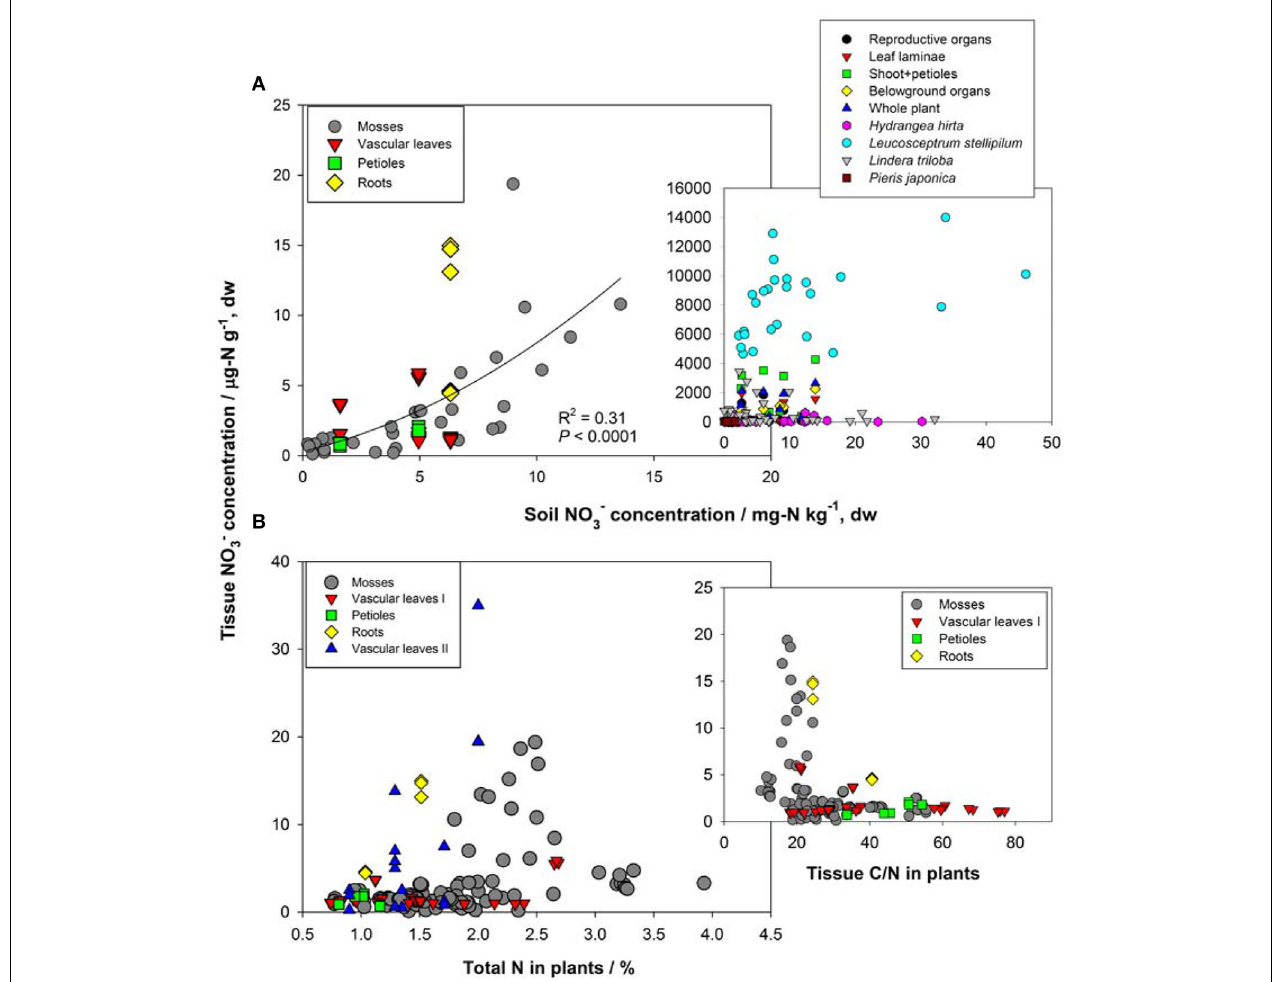
between total N, C/N, and tissue NO − 3 concentration in natural plants. Mosses include different species in different habitats of Guiyang, Southwestern China, and Western Tokyo, Japan (cited from Liu et al., 2012a,c). Vascular leaves I, petioles and roots were reported for a coniferous and a broadleaved plant in western Tokyo, Japan (cited from Liu et al., 2013a). Vascular leaves II included fern, oak, and pine species at the Camp Paivika and Camp Osceola forest sites in the San Bernardino Mountains of southern California, USA (cited from Fenn et al.,